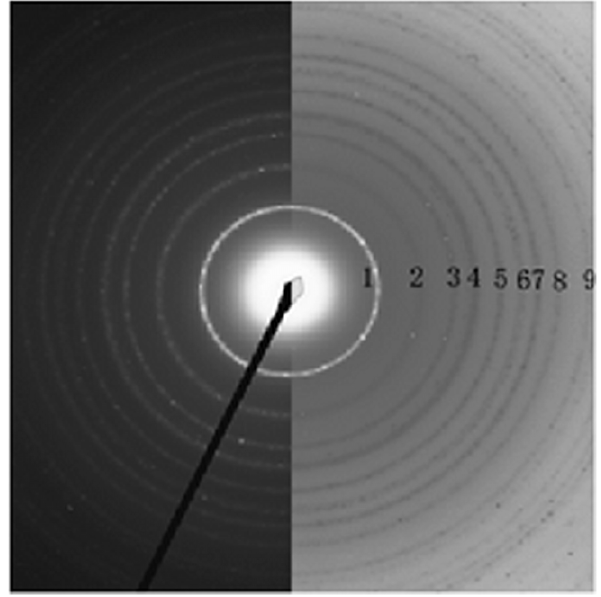
Figure 7. The diffraction rings of antase nanocrystals in details.